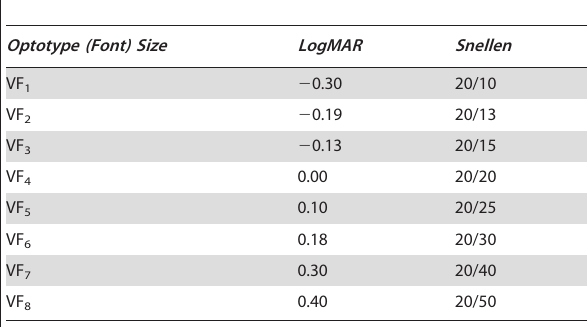
Table 4. Validation experiment optotype sizes.